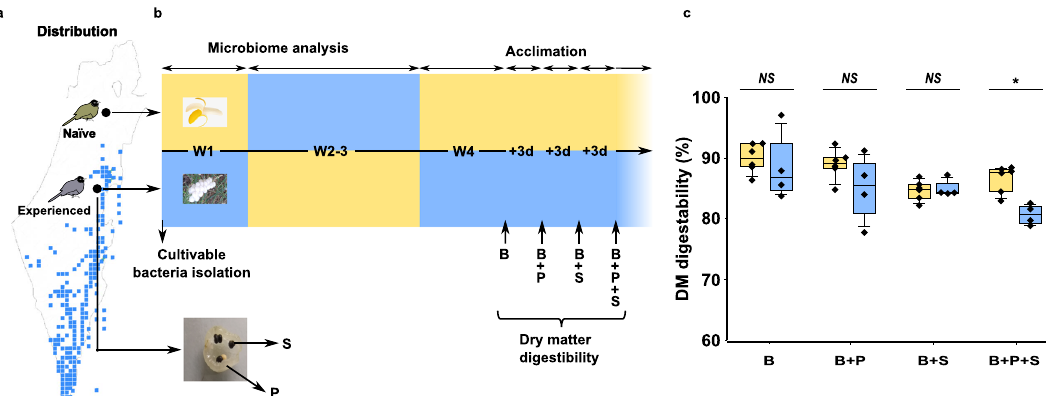
Fig. 1 | Ochradenus baccatus distribution map and Pycnonotus xanthopygos collection sites; experimental timeline; mixture of O. baccatus seed